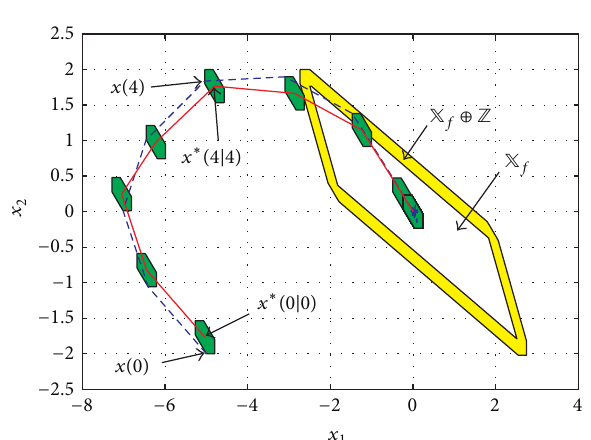
Figure 3: The phase trajectories from (−5,−2) ( 𝑁 = 9